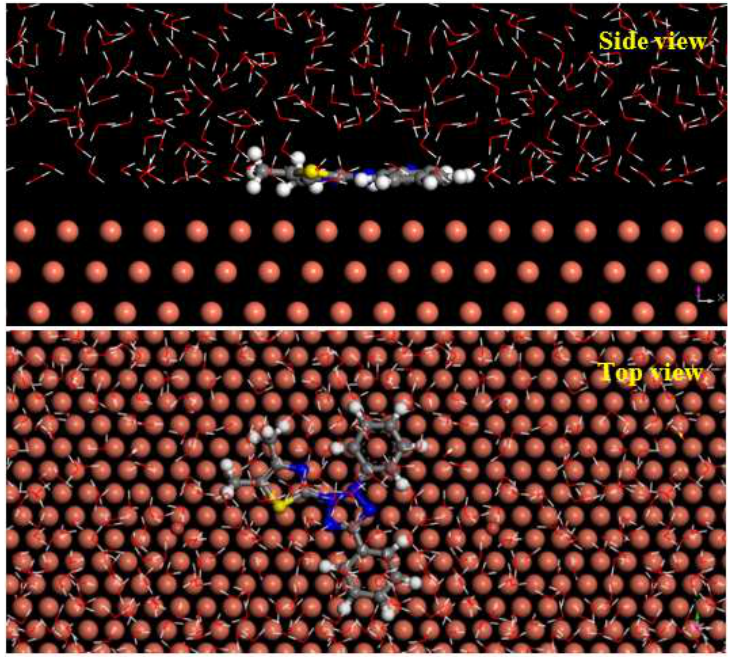
Figure 12. The equilibrium configuration of the molecular dynamics simulation for the MTT cation ( side view and top view ).